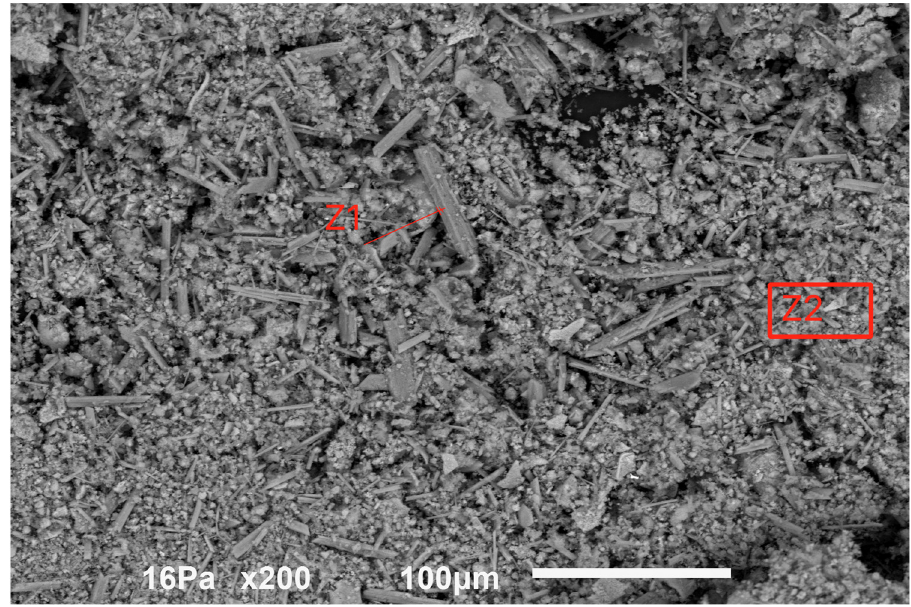
Figure 5 indicates a view of the sample dried at 105 °C.